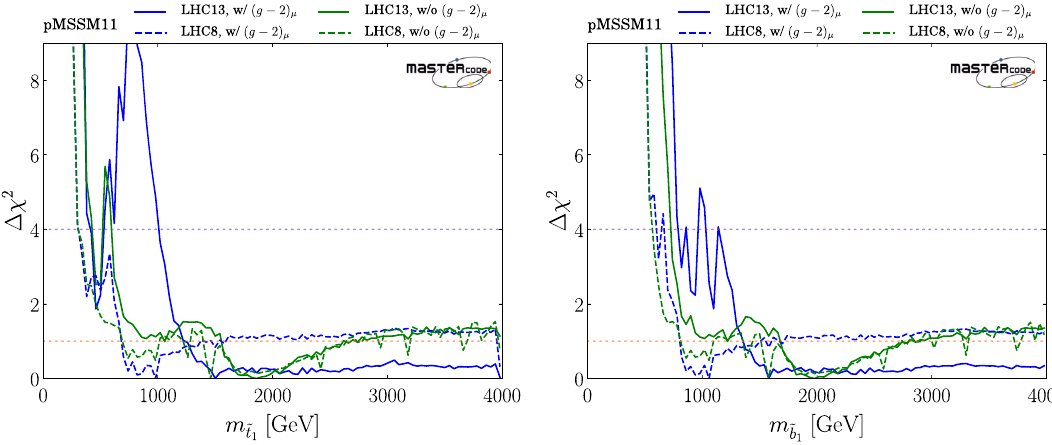
Fig. 8 Left panel: One-dimensional profile likelihood functions for the ˜ q mass in the pMSSM11 with (blue) and without the ( g − 2 ) μ constraint (green) and with (solid) and without (dashed) applying the constraints from LHC Run II. Right panel: Similarly for the ˜ g mass